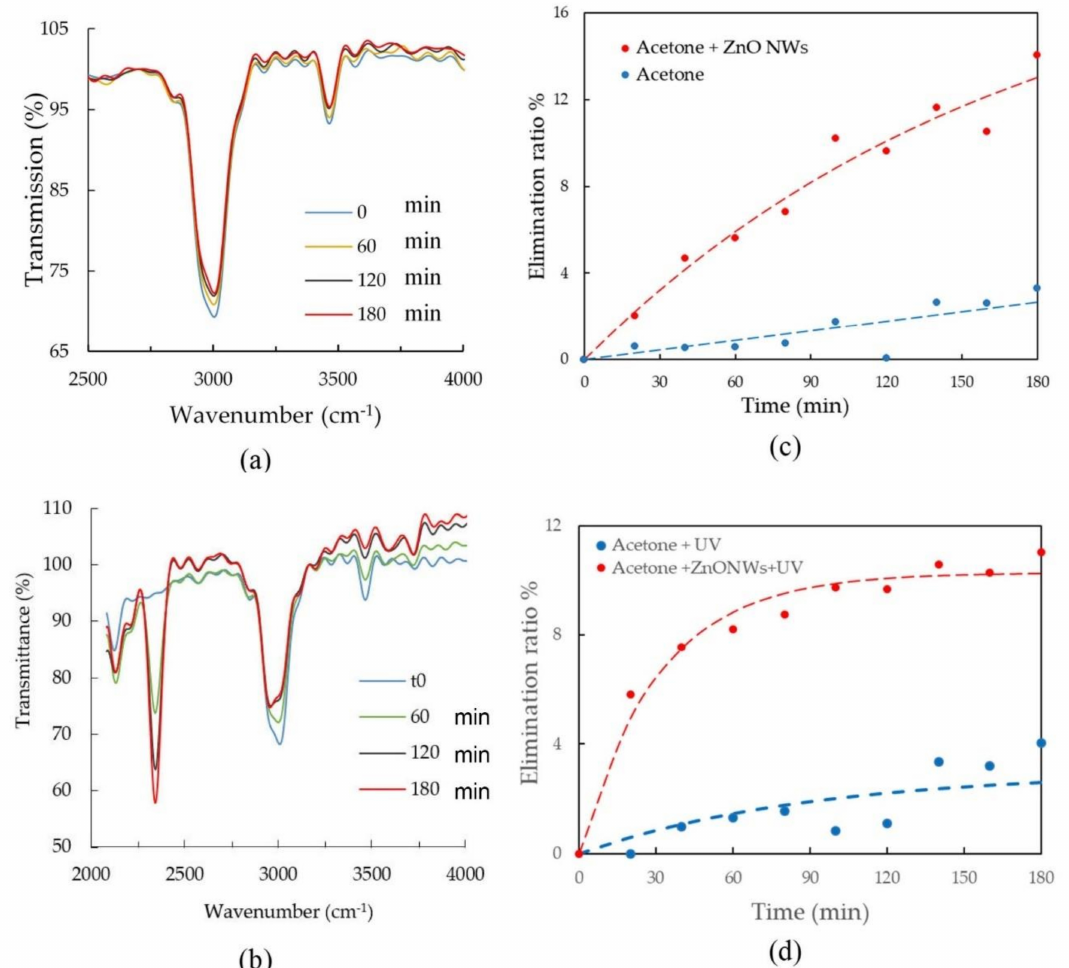
Figure 5. ( a , b ) Transmission of acetone measured using MEMS spectrometer at di ff erent measurement time (in min.) ( a ) without and ( b ) with the presence of UV. ( c , d ) The elimination ratio of acetone versus time in case of absence and presence of ZnO ( c ) without and ( d ) with the presence of UV. Dash lines represent exponential fit (1 − e − t / τ ) for the measured points, where τ is a time